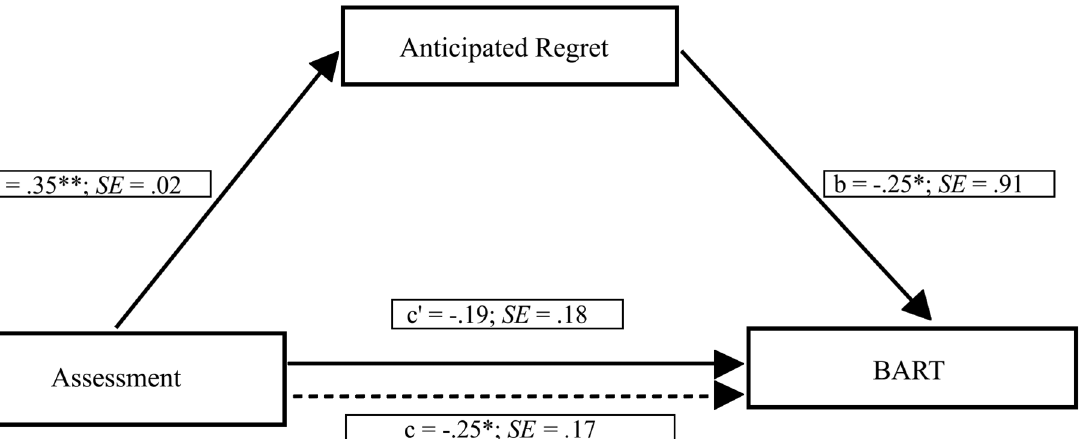
Fig 2. Mediation model showing the effect of the assessment orientation on risk-taking through anticipated regret. Path values represent standardized regression coefficients. The (c') value represents the effect, from bootstrapping analyses, of the assessment orientation on risk-taking after the mediator is included. Dotted line (c) represents the effect of the assessment orientation on risk-taking prior to the inclusion of anticipated regret. * p < .05; ** p < .001.